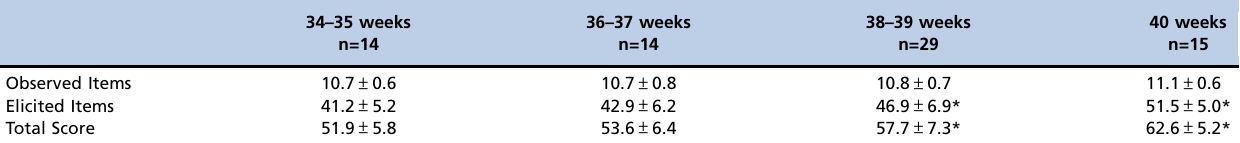
Table 2 - Progression of the Test of Infant Motor Performance scores in late preterm newborn infants according to the corrected gestational age